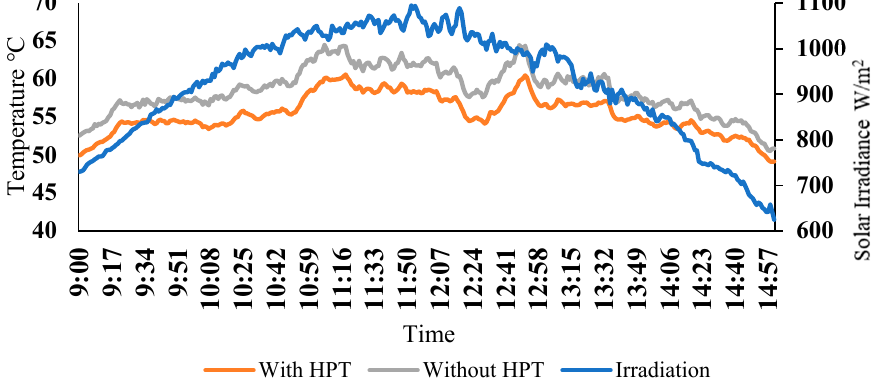
Figure 6. The temperature reference PV panel and the PV panel with 75 mL acetone.